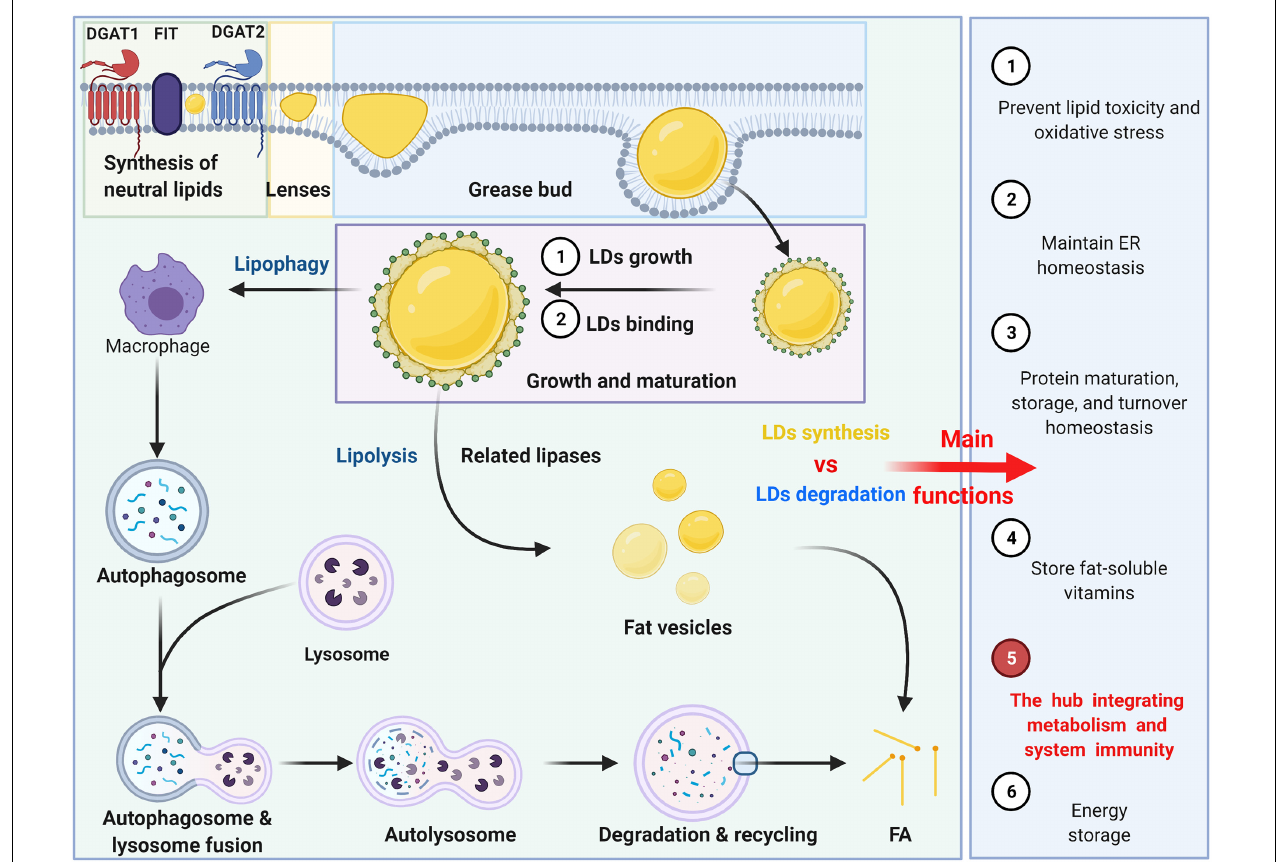
FIGURE 1 | The formation, degradation and main functions of LDs. The formation can be summarized into several conceptual steps: synthesis of neutral lipids and formation of lenses, grease bud, growth and maturation of LDs. The degradation of LDs can be divided into two ways: lipophagy and